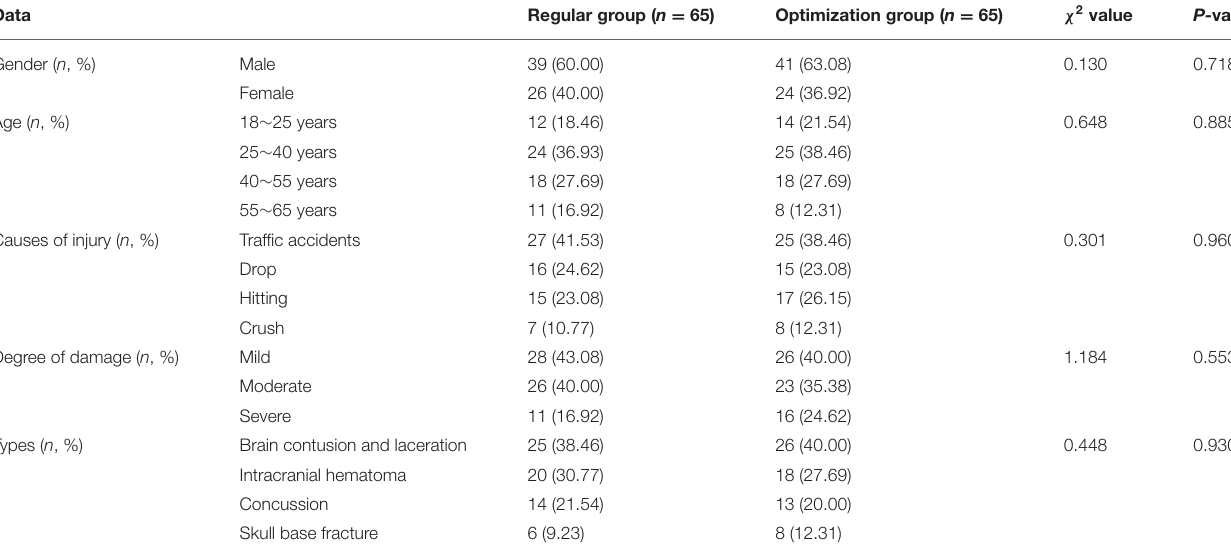
TABLE 1 | Comparison of baseline demographic information for the regular group and optimization